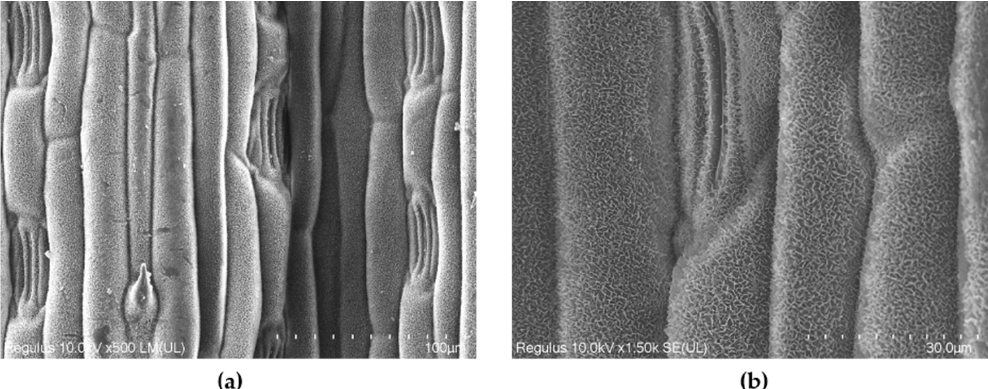
Figure 3. Scanning electron micrograph of the wheat leaf surface. Magnification: ( a ) 500 and ( b ) 1.5k.